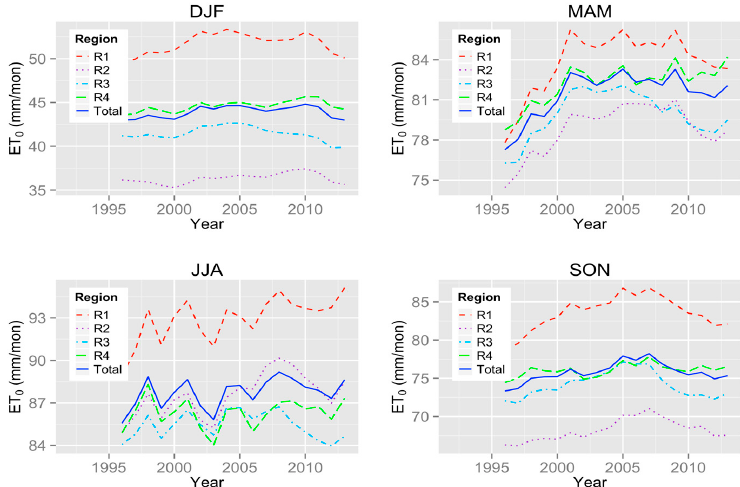
Figure 9. Annual trend in the 5-year moving average of monthly ET 0 in mm/month based on extended climate data for each season: DJF, MAM, JJA, and SON. The average for the whole study region is depicted as Total (solid blue line); the averages for R1, R2, R3, and R4 are presented using dashed red, dotted purple, dashed-dotted light blue, and dashed green lines, respectively.